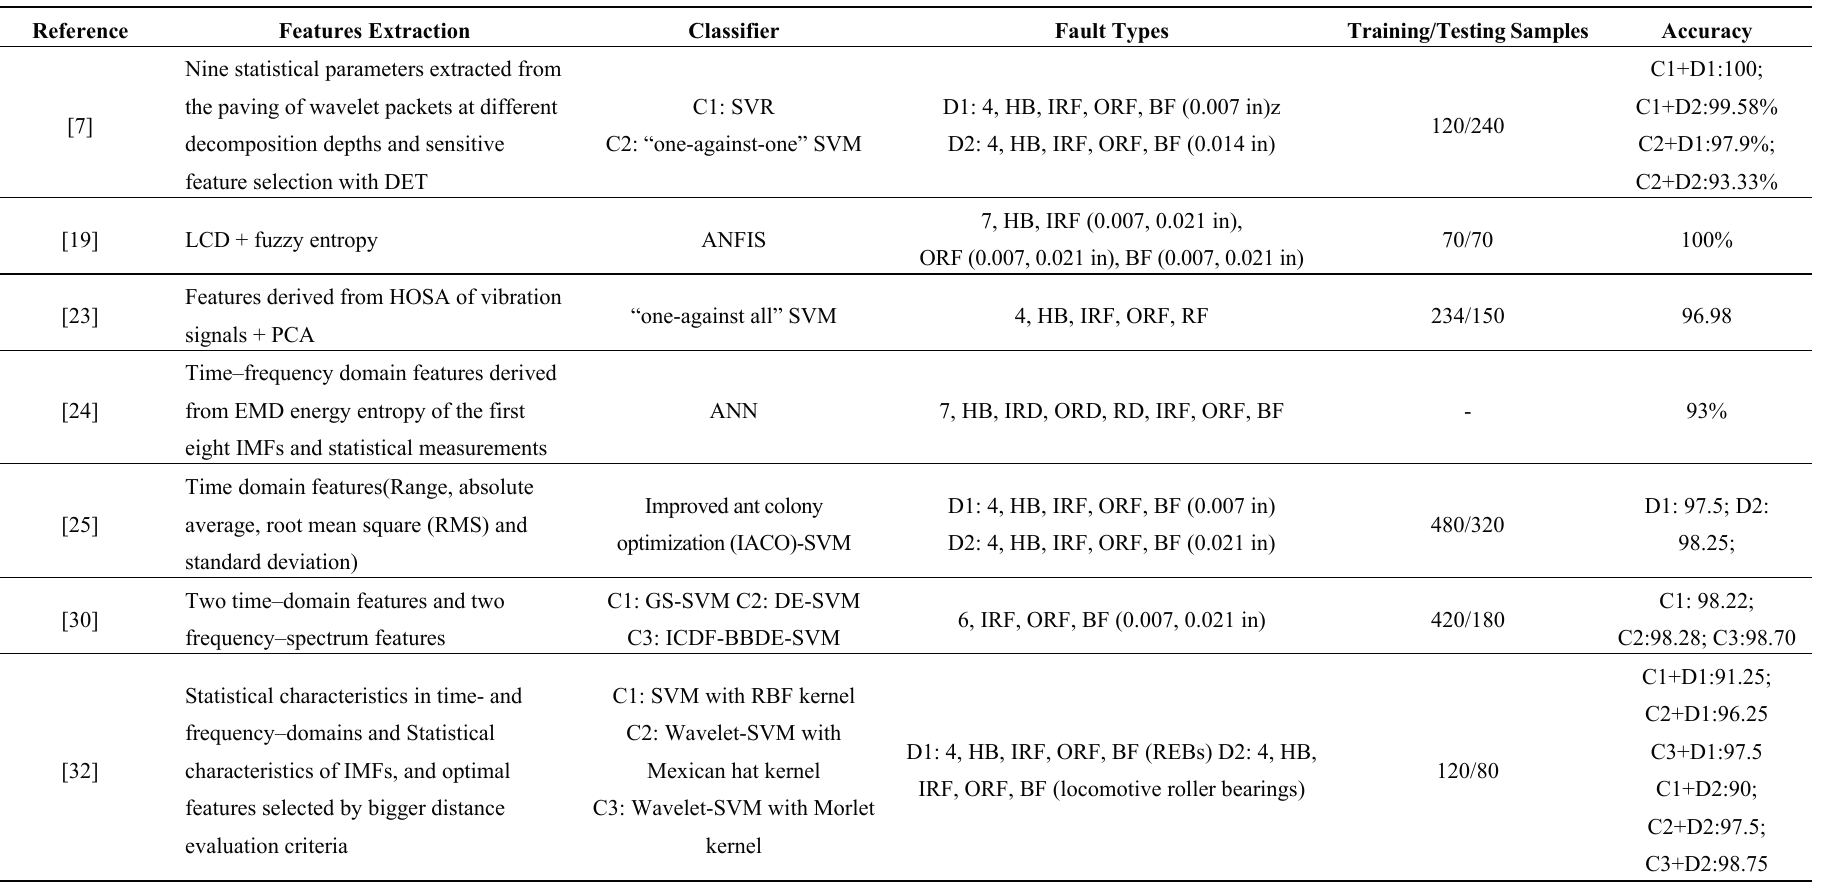
Table 8. Comparison between this paper with some previous research in the literature for REBs fault type and fault severity classification.